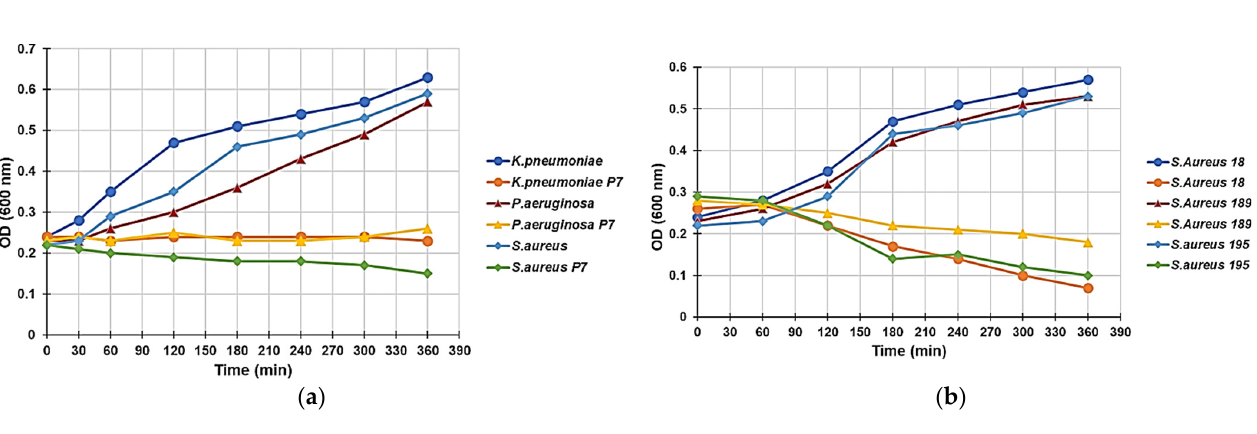
Figure 4. Effect of P7 (at 4 × MIC) on the growth curve of K. pneumoniae (strain 466), S. aureus (strain 18), and P. aeruginosa followed at 600 nm for a period of 6 h ( a ); effect of P7 (at 4 × MIC) on the growth curve of all S. aureus strains used in the experiments (strains 18, 189, and 195) followed at 600 nm for a period of 6 h ( b ).